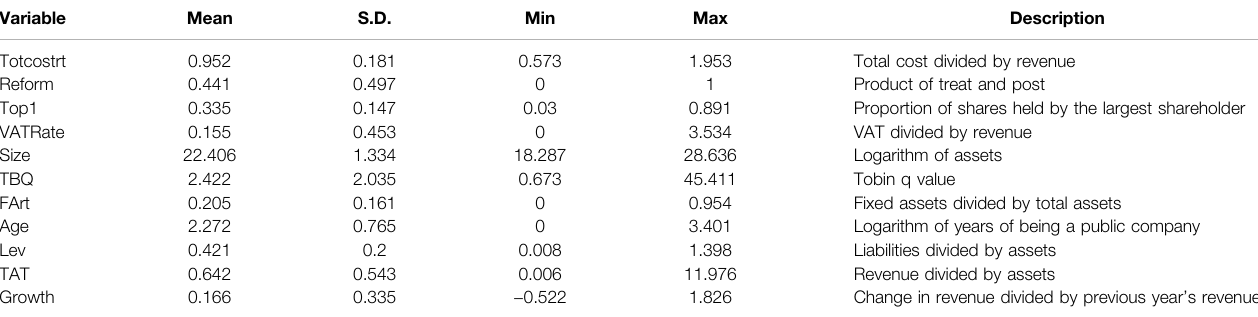
TABLE 1 | Summary statistics and description of the variables.